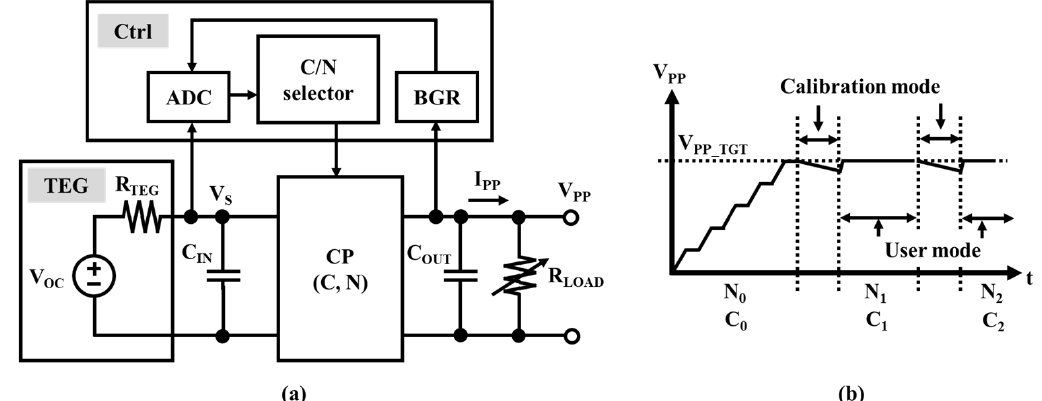
10 of 14 Figure 11. P OUT ( a ), η CP ( b ), η TEG ( c ), and η CP_MPPT ( d ) as a function of V OC in MPPT and a fixed 1–16 modes. 4.2. System Design Figure 12a,b show the CP system and V PP waveform in ramping up, calibration, and user modes, respectively [26]. V OC can be measured when V PP stays high. Because the A/D converter (ADC) and bandgap reference (BGR) are powered by V PP , one cannot know a value of V OC until V PP goes high. As a result, CP is set to the 1-16 mode initially, which can be boosted up to a target V PP of 3 V even with low V OC . In the above demonstration, N 0 and C 0 are 16 and 20 pF, respectively. Once V PP reaches a target of 3 V, a calibration mode starts. The oscillator to drive CP is disabled to increase the input impedance of CP suffi- ciently high. After the input voltage V S is saturated to be close to V OC , ADC measures the V OC value for C/N selector to determine the logic values for the CP control signals such as ES 1 and EP 1. CP is reconfigured to the optimum one for the current value of V OC . Even